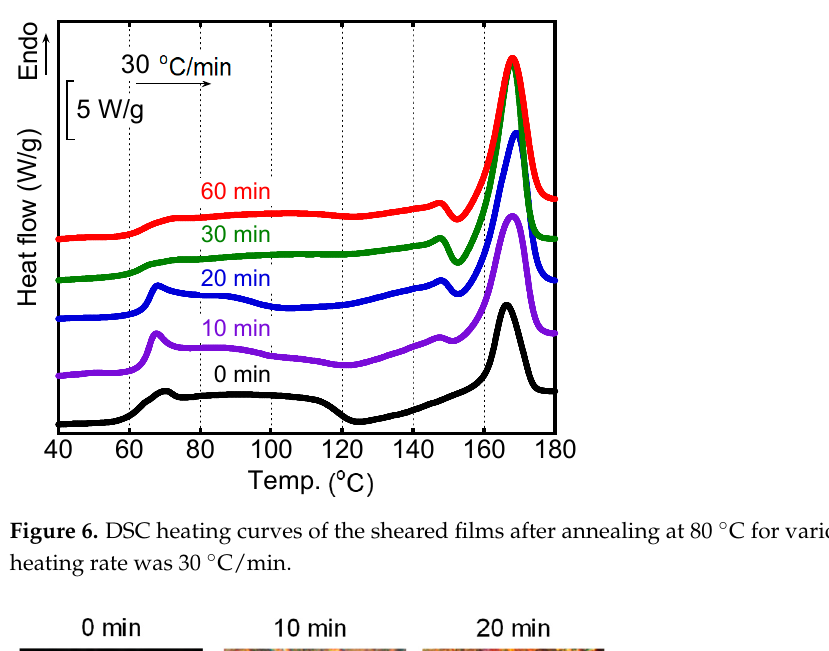
Figure 6. DSC heating curves of the sheared films after annealing at 80 °C for various periods. The heating rate was 30 °C/min.